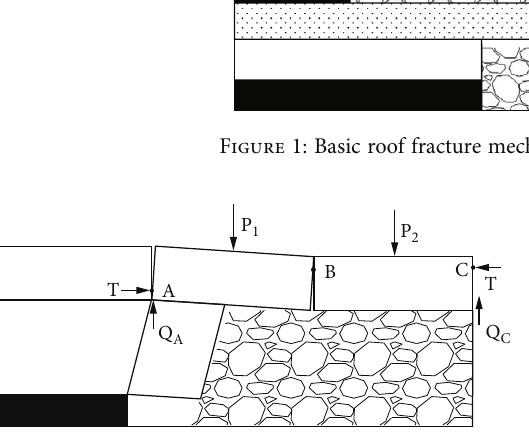
Figure 2: Structural model of main roof after fracture.